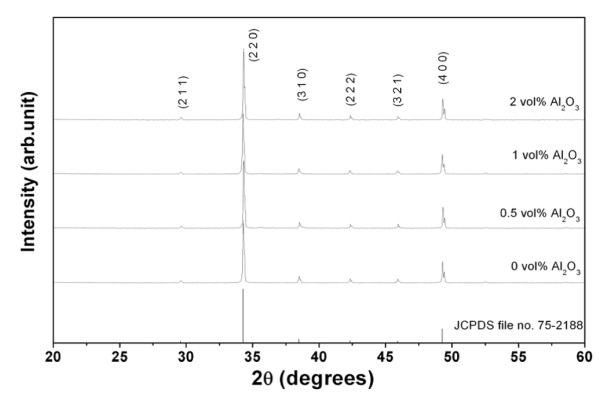
XRD patterns of the surfaces of the CC3.1TO and CC3.1TO-Al2O3 pellets.